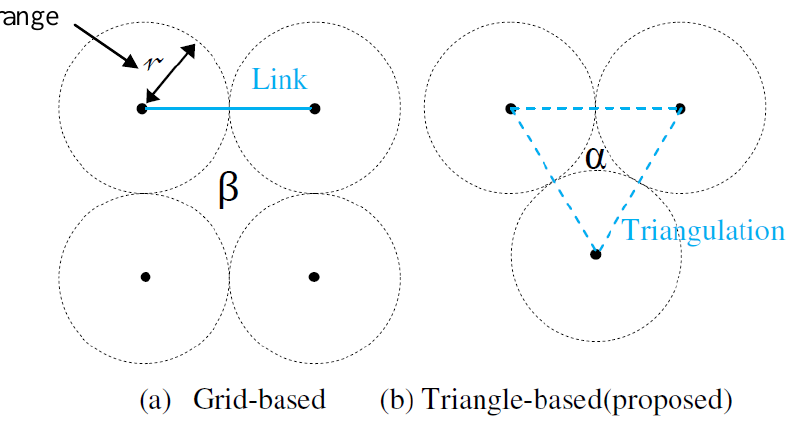
Figure 1. Detection capacity-based sensor deployment.